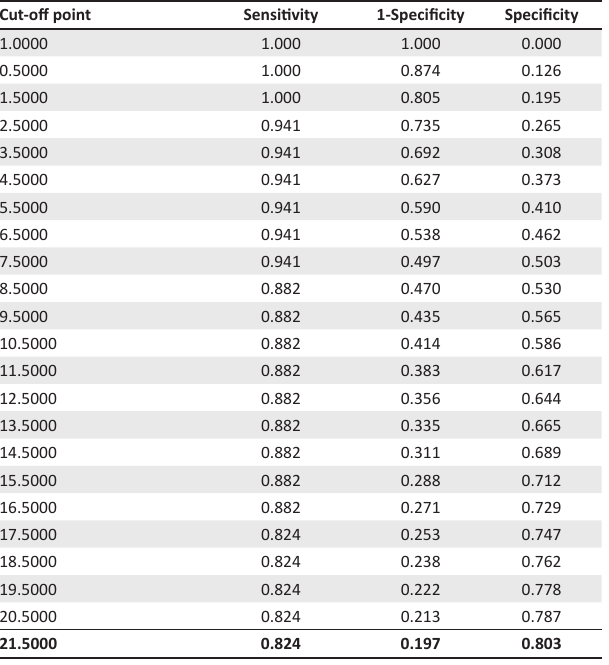
TABLE 3: ROC curve coordinates of the Beck anxiety inventory using the SCID as the gold standard. Cut-off point